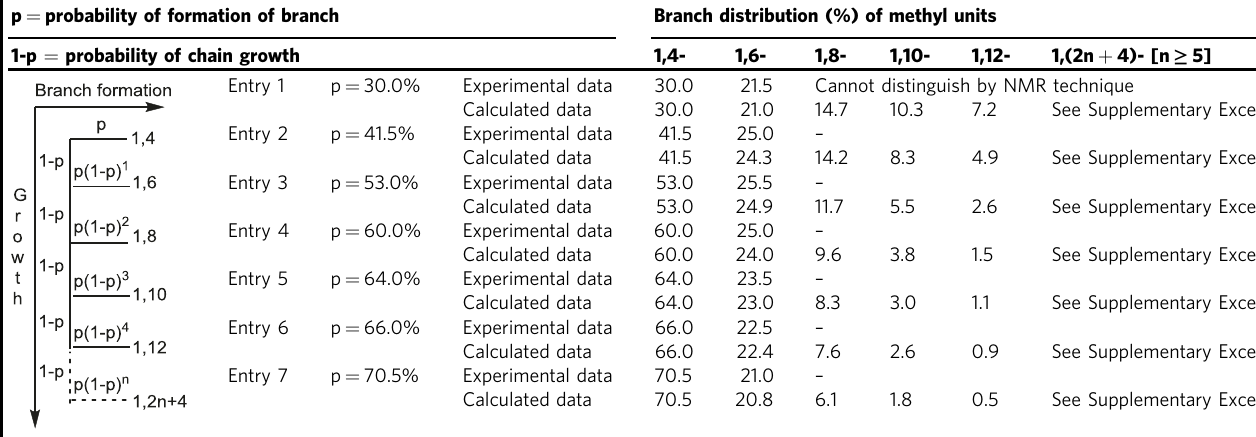
Table 3 Precise analysis of branch distributions by a statistical model of probability. p = probability of formation of branch Branch distribution (%) of methyl